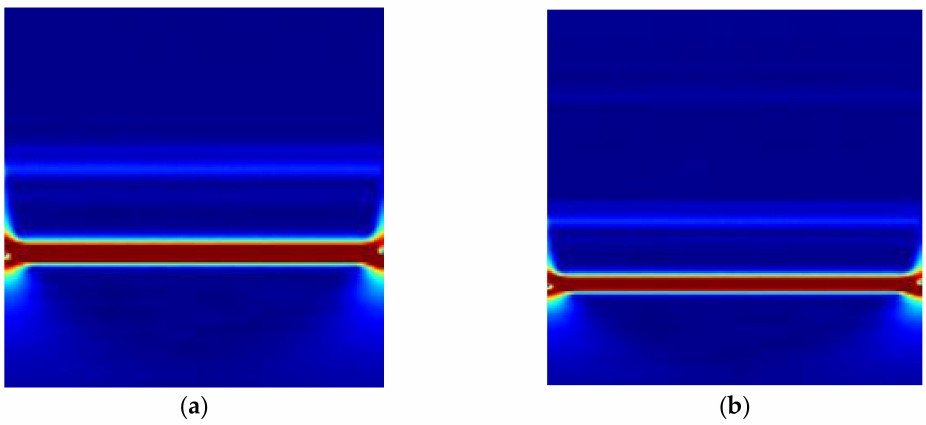
Figure 8. Example of scalograms from current signal: ( a ) decimated sampling frequency and ( b ) non- decimated sampling